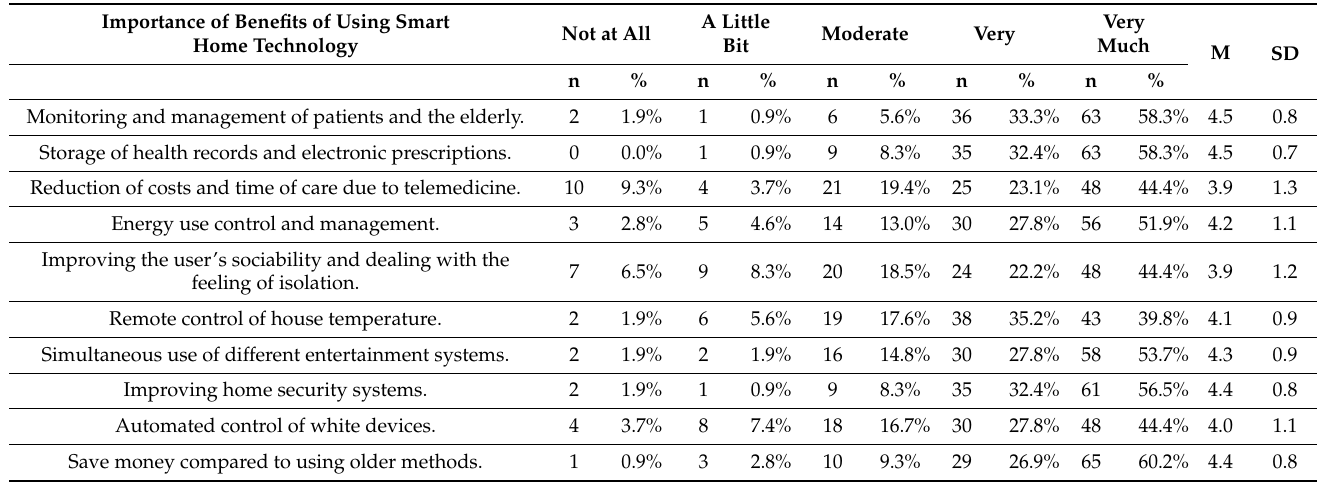
Table A9. Benefits of using smart home technology.